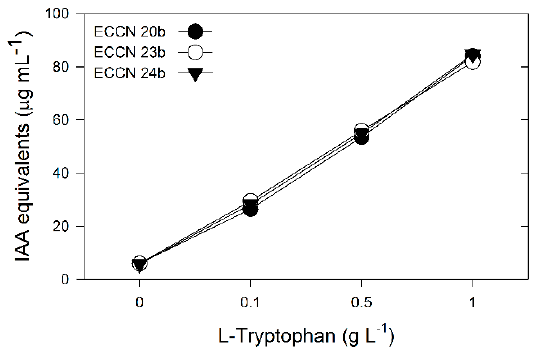
Figure 3. Indolic compound formation by cultures of Proteus ECCN 20b, Proteus ECCN 23b and Serratia ECCN 24b in response to increasing L-trp concentration. Results are from three experiments and expressed as the mean ± S.E.